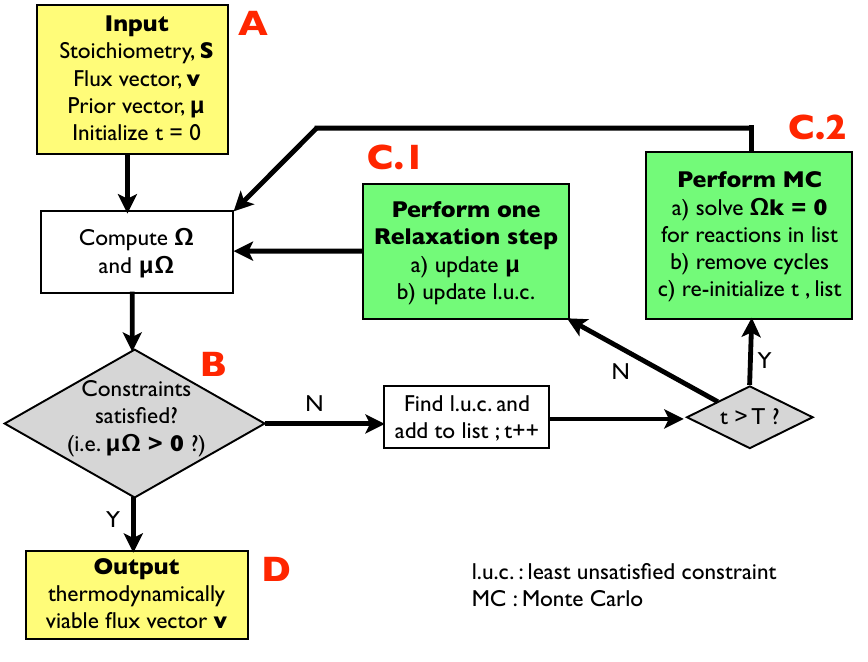
Figure 1. Flowchart of the algorithm for counting and removing cycles employed in this study. See text for